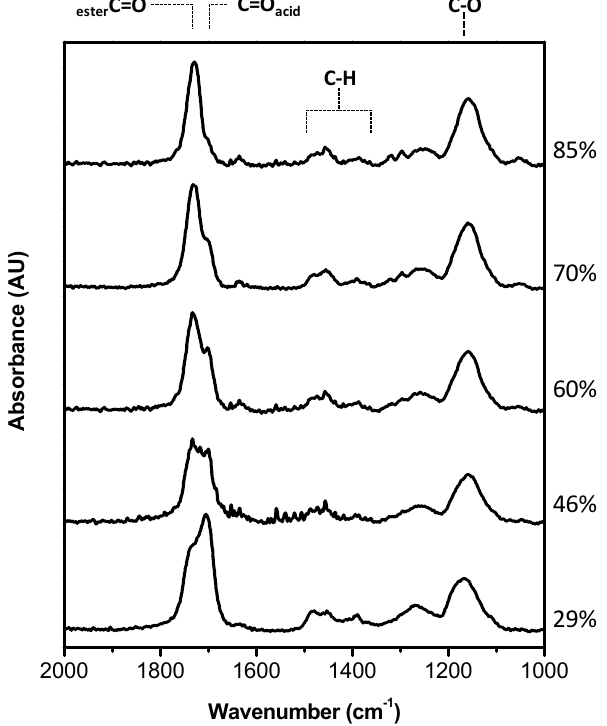
Figure 1. Fourier Transform Infrared (FT-IR) spectra of different copolymers with different methacrylic acid (MAA)/ ethylene glycol dimethacrylate (EGDMA) composition. Percentages on the right are EGDMA film volume fractions.